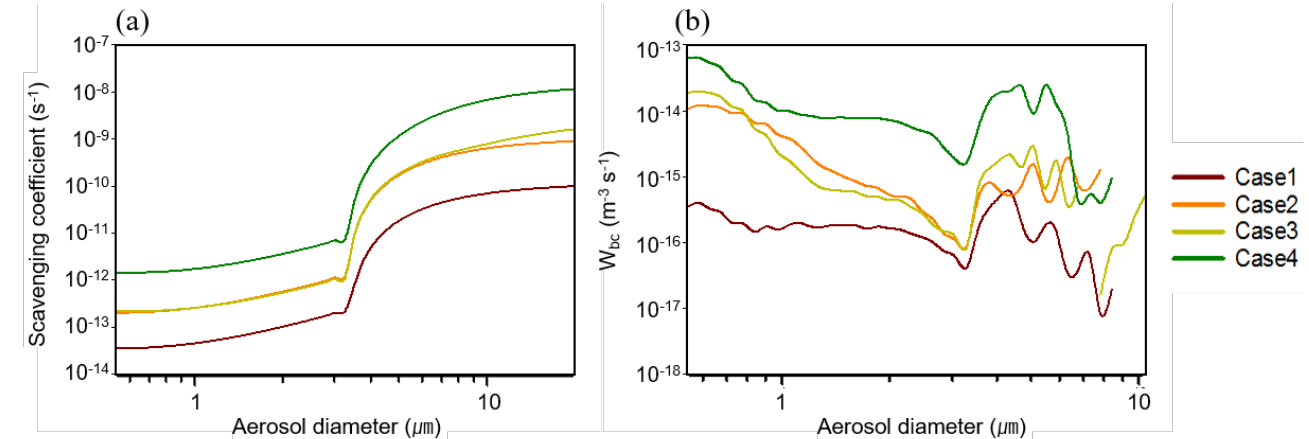
Figure 6. Variation of ( a ) scavenging coefficient and ( b ) below-cloud scavenging rate as a function of aerosol diameter in Cases 1 to 4.